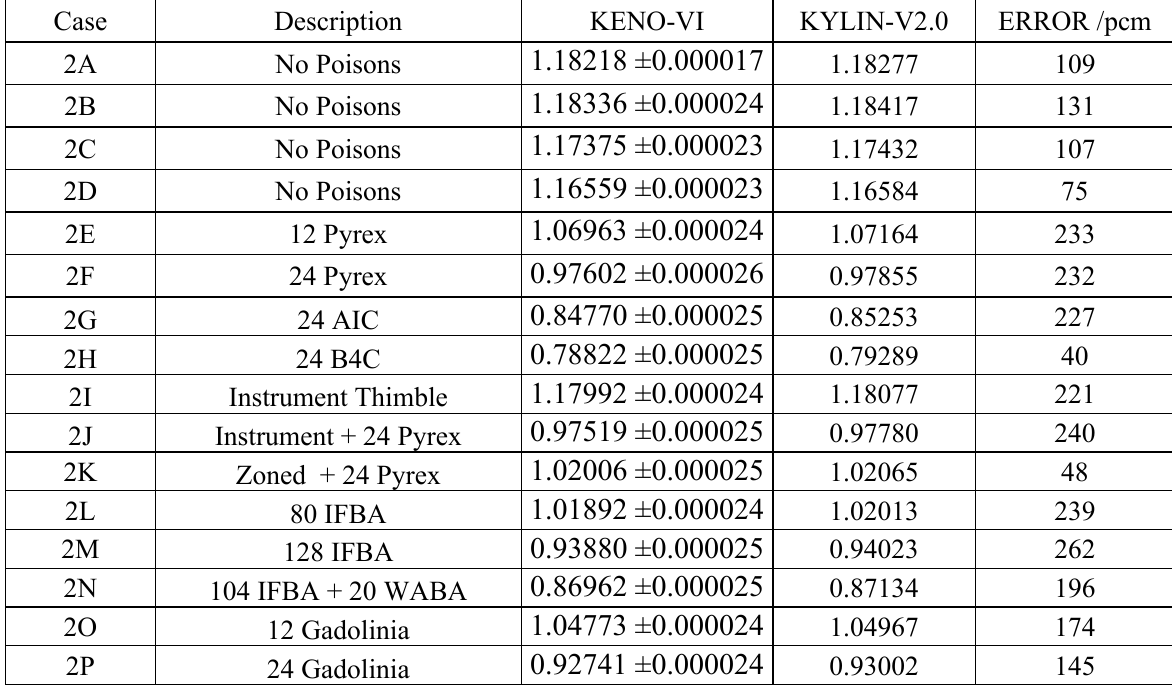
Table III. Comparison of effective multiplication factor for 2D HZP fuel lattice